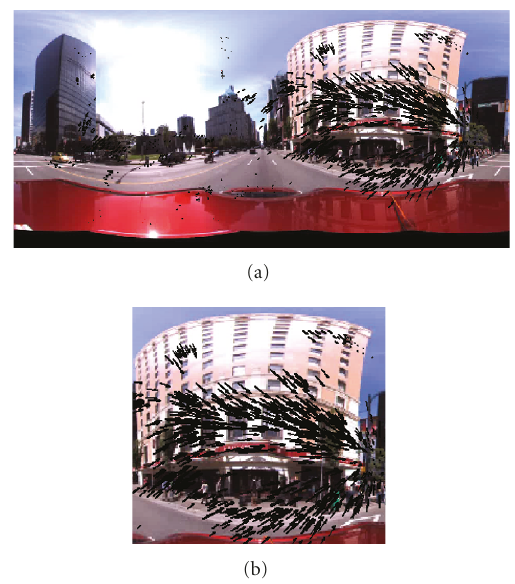
Figure 14: (a) Smoothed oriented CSR matches, (b) zoomed right region.